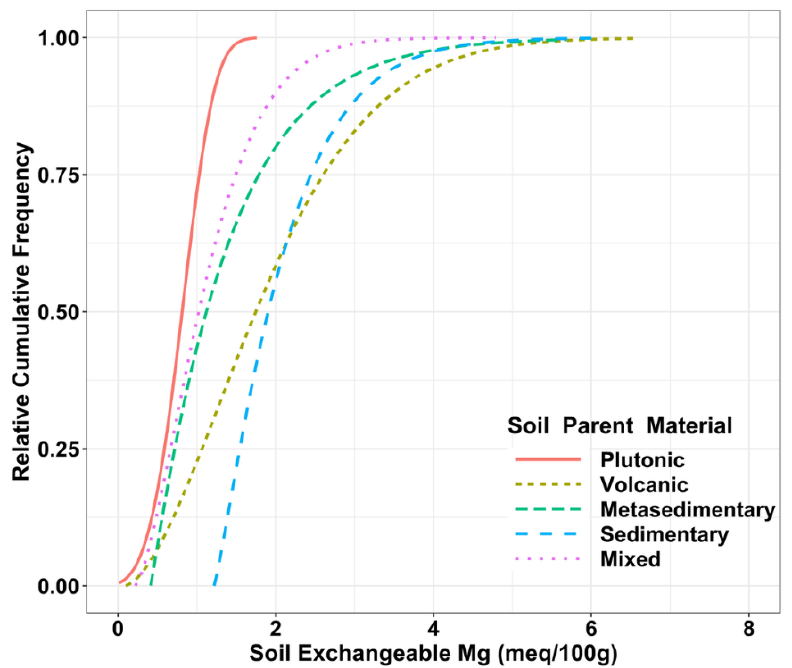
Figure 4. Soil exchangeable magnesium cumulative distributions for different bedrock soil parent materials in the Inland Northwest, USA.